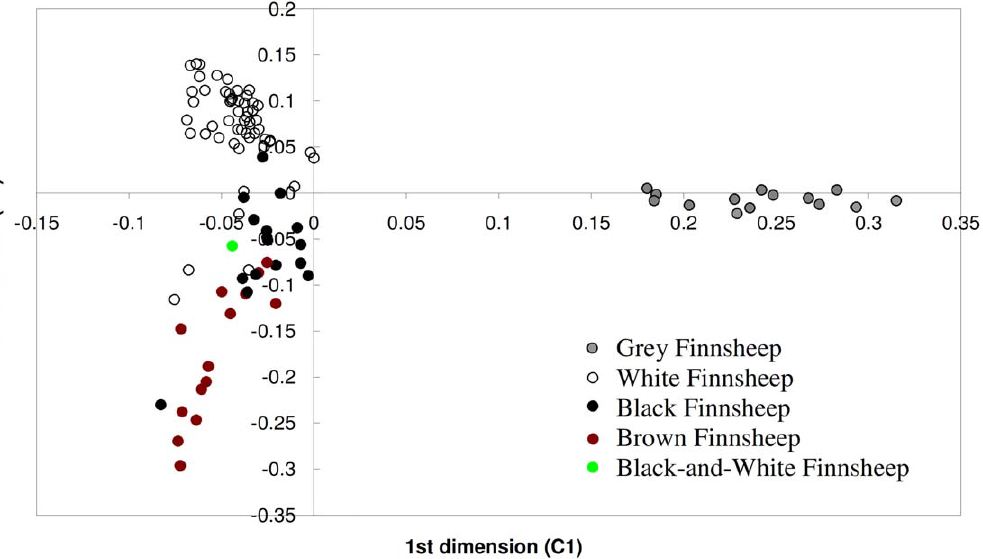
Figure 1. Clustering of the individual Finnsheep based on multidimensional scaling of genetic distance. The first (C1) and second (C2) dimensions are plotted.